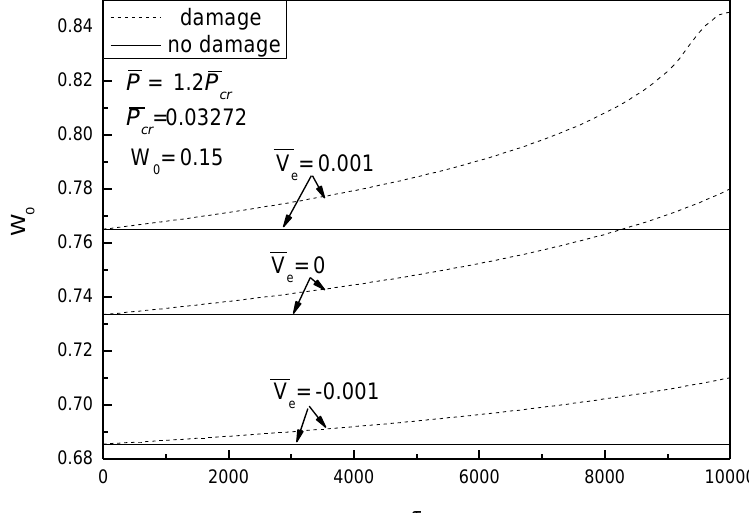
Figure 12. Effect of electrical loads on postbuckling response curves of piezoelectric plate with damage and initial